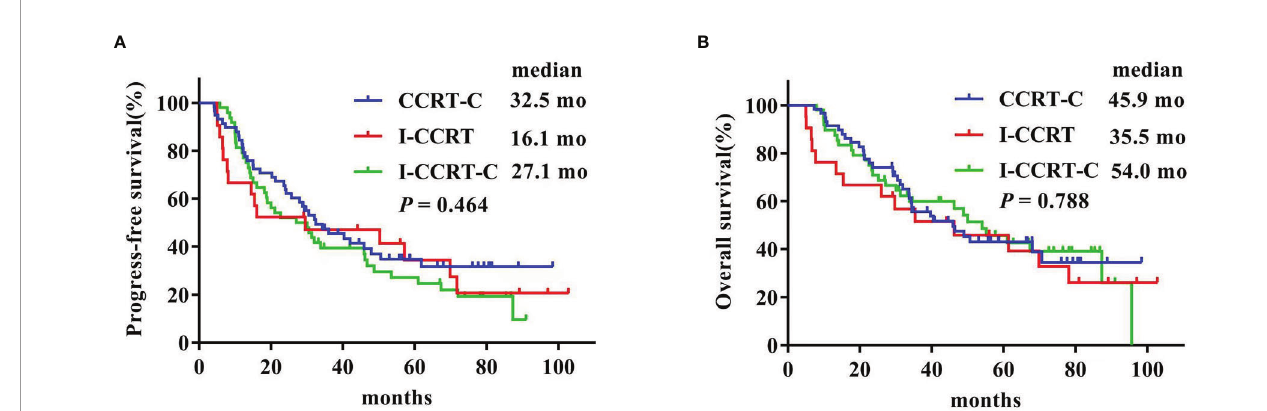
FIGURE 1 | Kaplan – Meier curves of progress-free survival (A) and overall survival